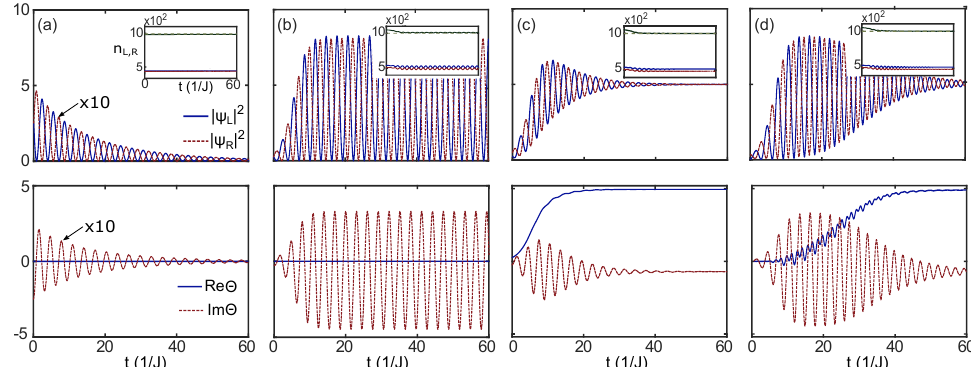
Figure 2. Dynamics of the polariton populations | ψ L , R | 2 (upper panels), the reservoir excitons n L , R (insets), and the coherence Θ (lower panels), as obtained from the numerical solution of Equations (1) and (2) for the parameters (cid:101) L , R = 0, κ = 10 J , Γ = 2 J , R = 0.02 J (time is in units of J − 1 ), corresponding to the threshold values of pumping P L + P R = 2 κ Γ / R = 2000 J and the steady- state exciton populations n L + n R = 2 κ / R = 1000 (green dashed lines in the insets). The initial exciton populations are always taken as n L , R = P L , R / Γ , while the initial polariton amplitudes ψ L , R are seeded with small (complex) values. ( a ) Linear case ( η = 0) with the pumping rates P L = 1000 J and P R = 990 J being slightly below threshold, leading to a decay in the initial polariton populations | ψ ( t ) | 2 and | ψ ( t ) | and steady-state exciton population n + n < 2 κ / R . ( b ) Same as in ( a ), but for L R L R stronger pumping rates P L = 1080 and P R = 1020 above threshold and initial conditions Re Θ ( 0 ) = 0, leading to the initial build-up of the polariton populations and their continuous Rabi-like oscillations, while Re Θ ( t ) = 0 ∀ t , and the exciton population n L + n R oscillating slightly above the threshold value 2 κ / R = 1000. ( c ) Same as in ( b ), but for the initial conditions Re Θ ( 0 ) (cid:54) = 0, leading to a steady-state of the system. ( d ) Same as in ( b ) with the initial conditions Re Θ ( 0 ) = 0, but in the presence of nonlinearity η = 0.1 J that couples Re Θ and Im Θ , leading to a steady-state of the